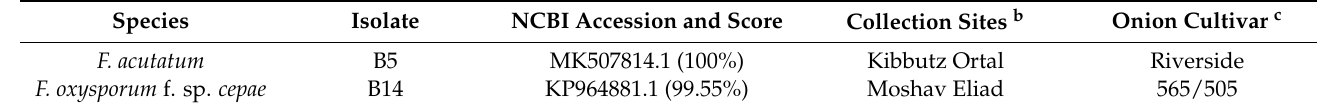
Table 1. Fusarium isolates used in this study a